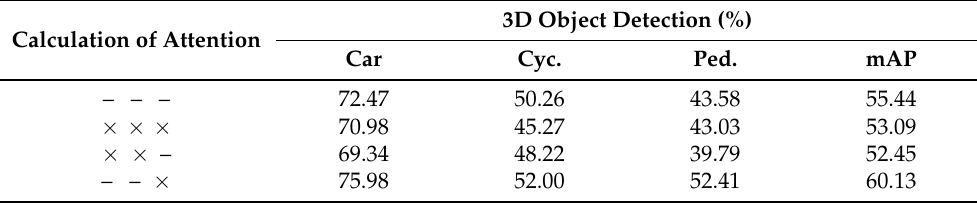
Table 7. Comparison of calculation ways of attention. The three consecutive symbols represent the way of attention computation used in PTD, PTU, and PFT, where – stands for subtraction, × for multiplication.